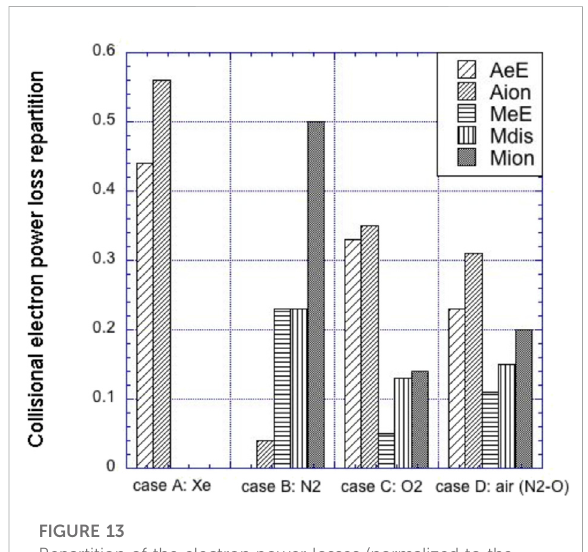
FIGURE 13 Repartition of the electron power losses (normalized to the total collisional power loss) among the main electron-gas collisional channels (MeE: molecular electronic excitation, Mdis: molecular dissociation, Mion: molecular ionization, AeE: atomic electronic excitation, and Aion: atomic ionization) for the different